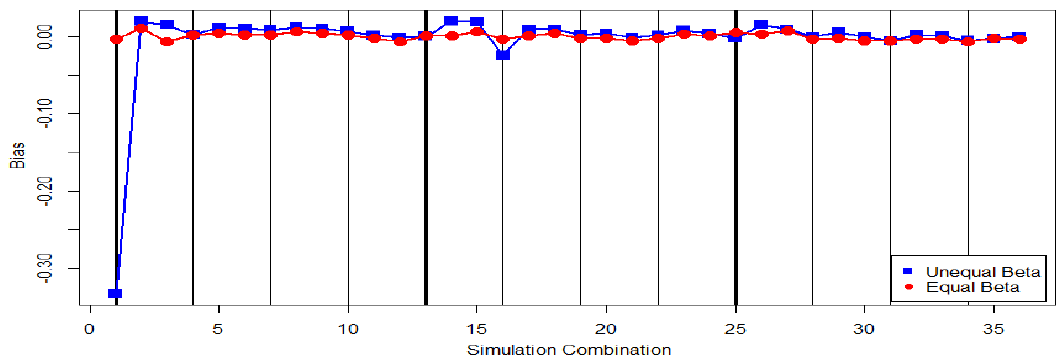
Figure 1. The bias of ˆ δ SE for the cases of β 1 = β 2 and β 1 (cid:54) = β 2 .